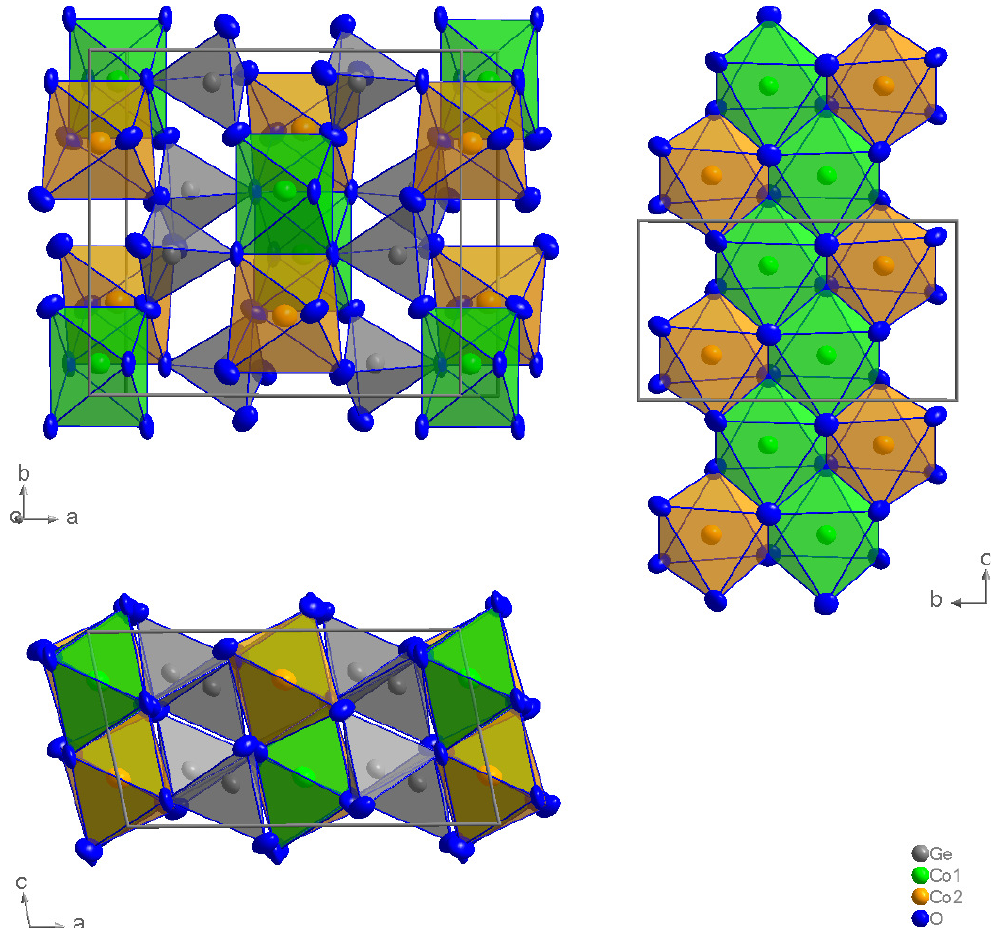
Figure 1. Crystal structure of CoGeO 3 . The atoms are indicated by 99.9% probability ellipsoids obtained from single crystal X-ray diffraction (see Tables 1 and 2); grey : germanium (Ge1), green : cobalt (Co1), dark yellow : cobalt (Co2) and blue : oxygen (O1–O3)